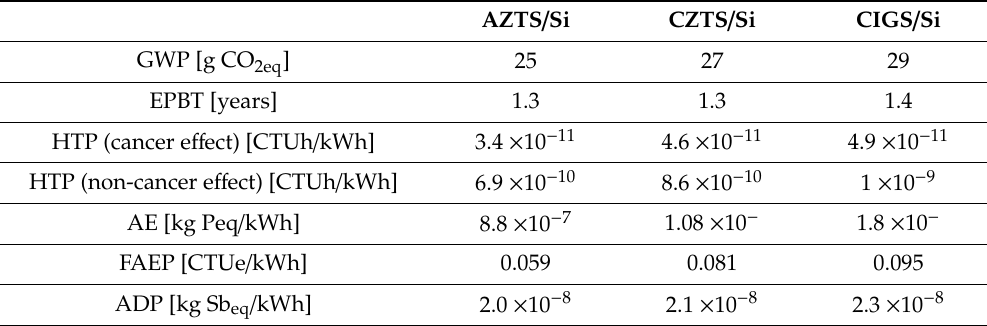
Table 10. Environmental impact results for chalcogenide / Si solar modules